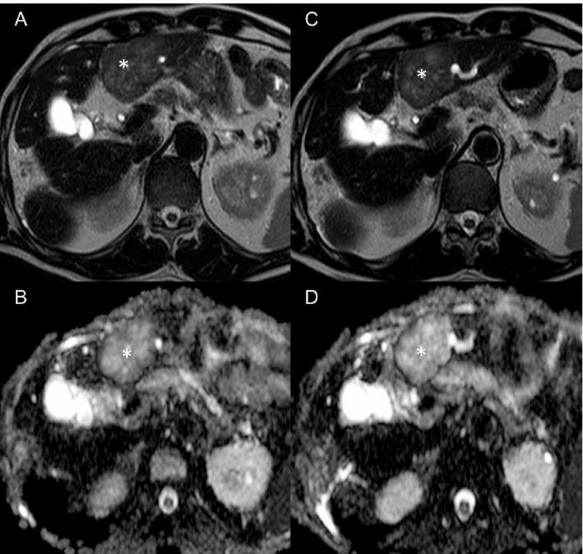
Figure 3. Imaging of patient 16 with colorectal carcinoma and liver metastases (marked with an asterisk) before ( A , B ) and after ( C , D ) the second cycle shows an increase in ADC value ( B + D ) and changes in T2 weighted imaging ( A + C ). These morphological changes can be further assessed with the multiparametric MRI